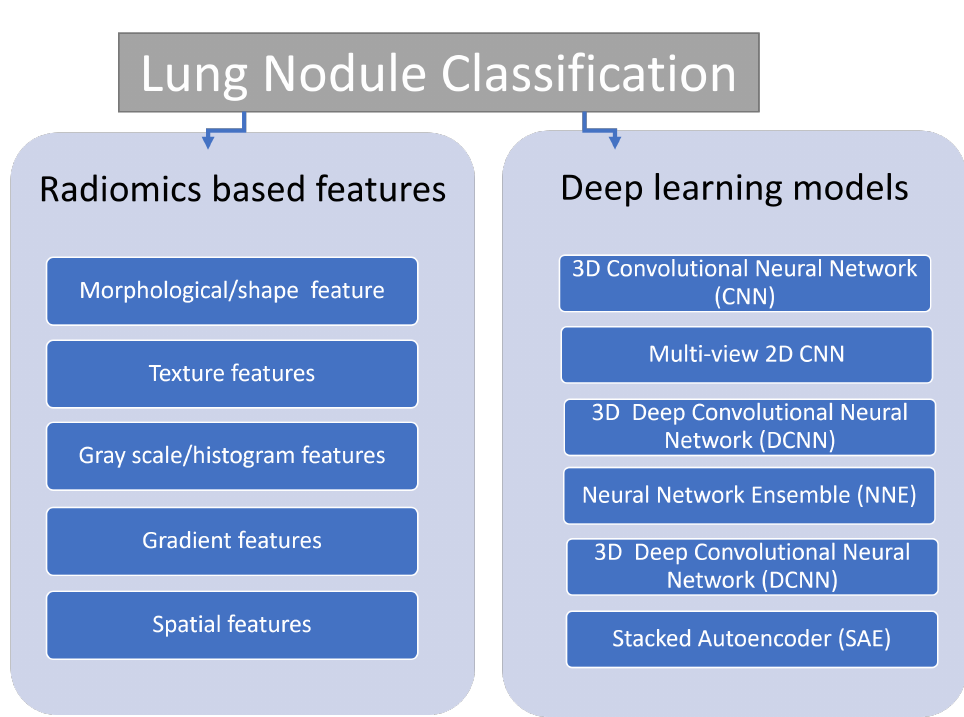
Figure 3. Main Categories of Lung Nodule Classification. The process of nodule classification requires analysis of data obtained from 3D